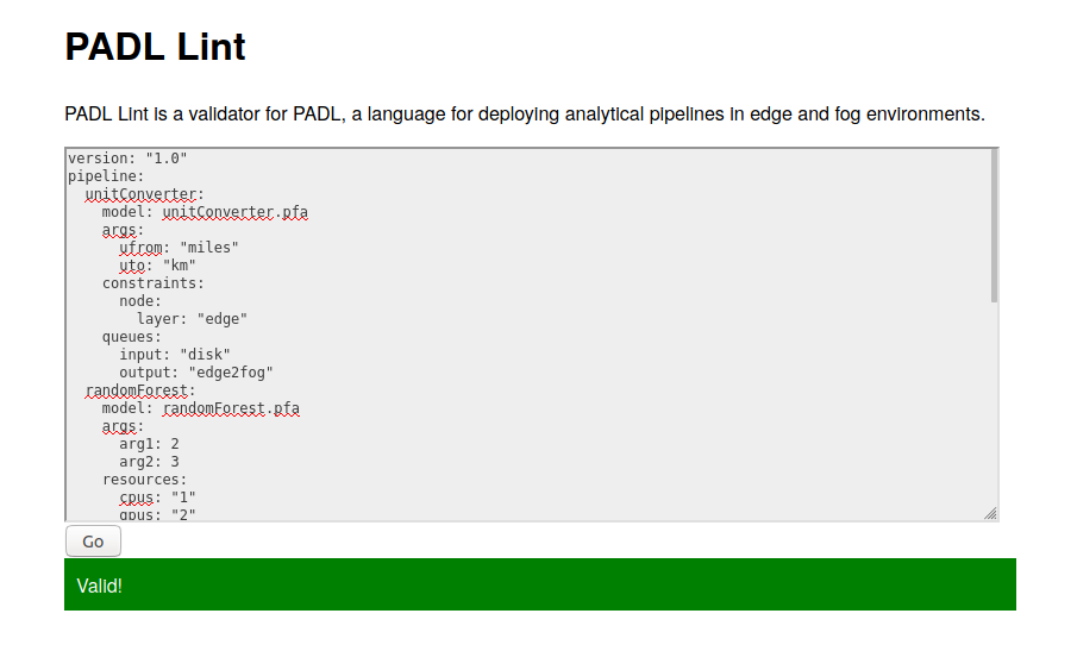
Figure 19. Screenshot of the Web Lint utility validating a PADL